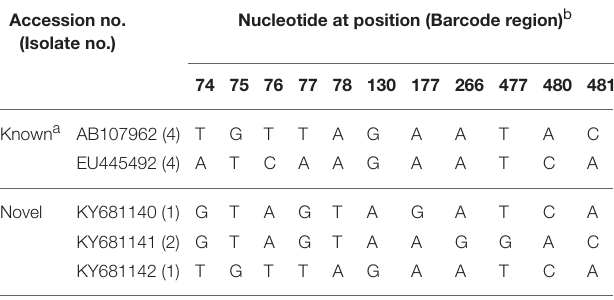
TABLE 3 | Nucleotide variations in the barcode region of the SSU rRNA gene of Blastocystis ST1 isolates in this study. Accession no. (Isolate